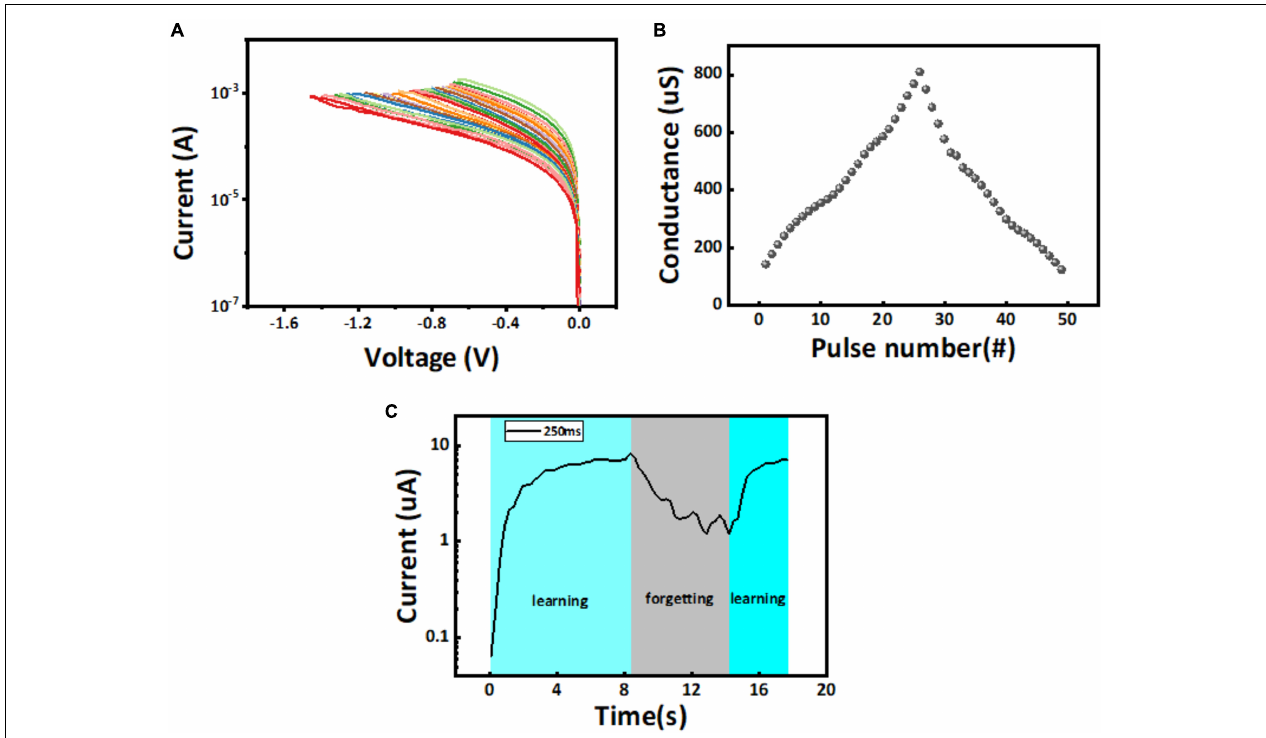
FIGURE 2 | (A) Continuous regulation of the device current in the negatively biased reset processes. (B) Evolution of the device conductance as a function of the voltage pulse stressing numbers. All the voltage pulses show the same width of 200 ms and amplitude of 1.8 V. (C) The simulation of learning–forgetting–learning process based on long-term potentiation (LTP) with the positive voltage (pulse width of 200 ms, pulse interval of 50 ms, and amplitude of − 0.4 V) and long-term depression (LTD) with the negative voltage (pulse width of 200 ms, pulse interval of 50 ms, and amplitude of − 0.4 V) of memristor